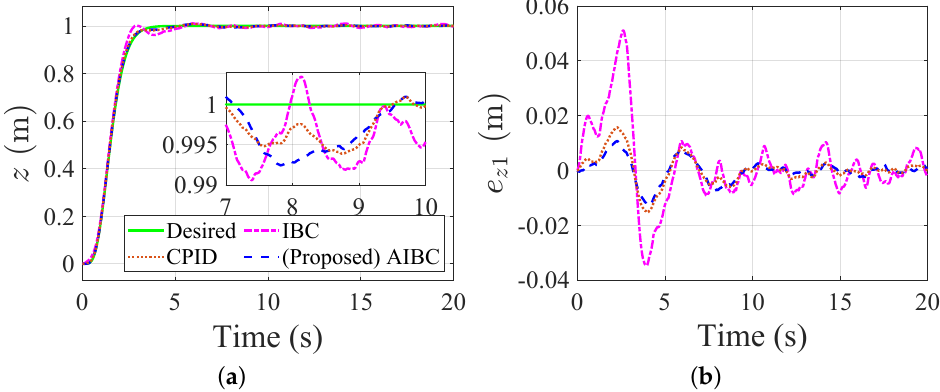
Figure 6. Comparison of the desired command and system response in the z -direction for different approaches. ( a ) desired command and actual states; ( b ) tracking